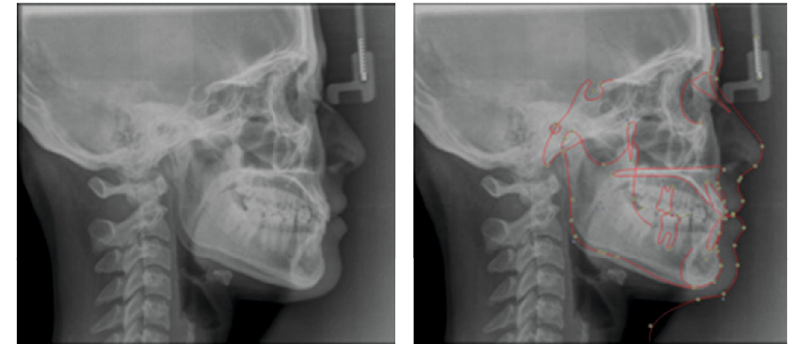
Figure 2: Pretreatment lateral